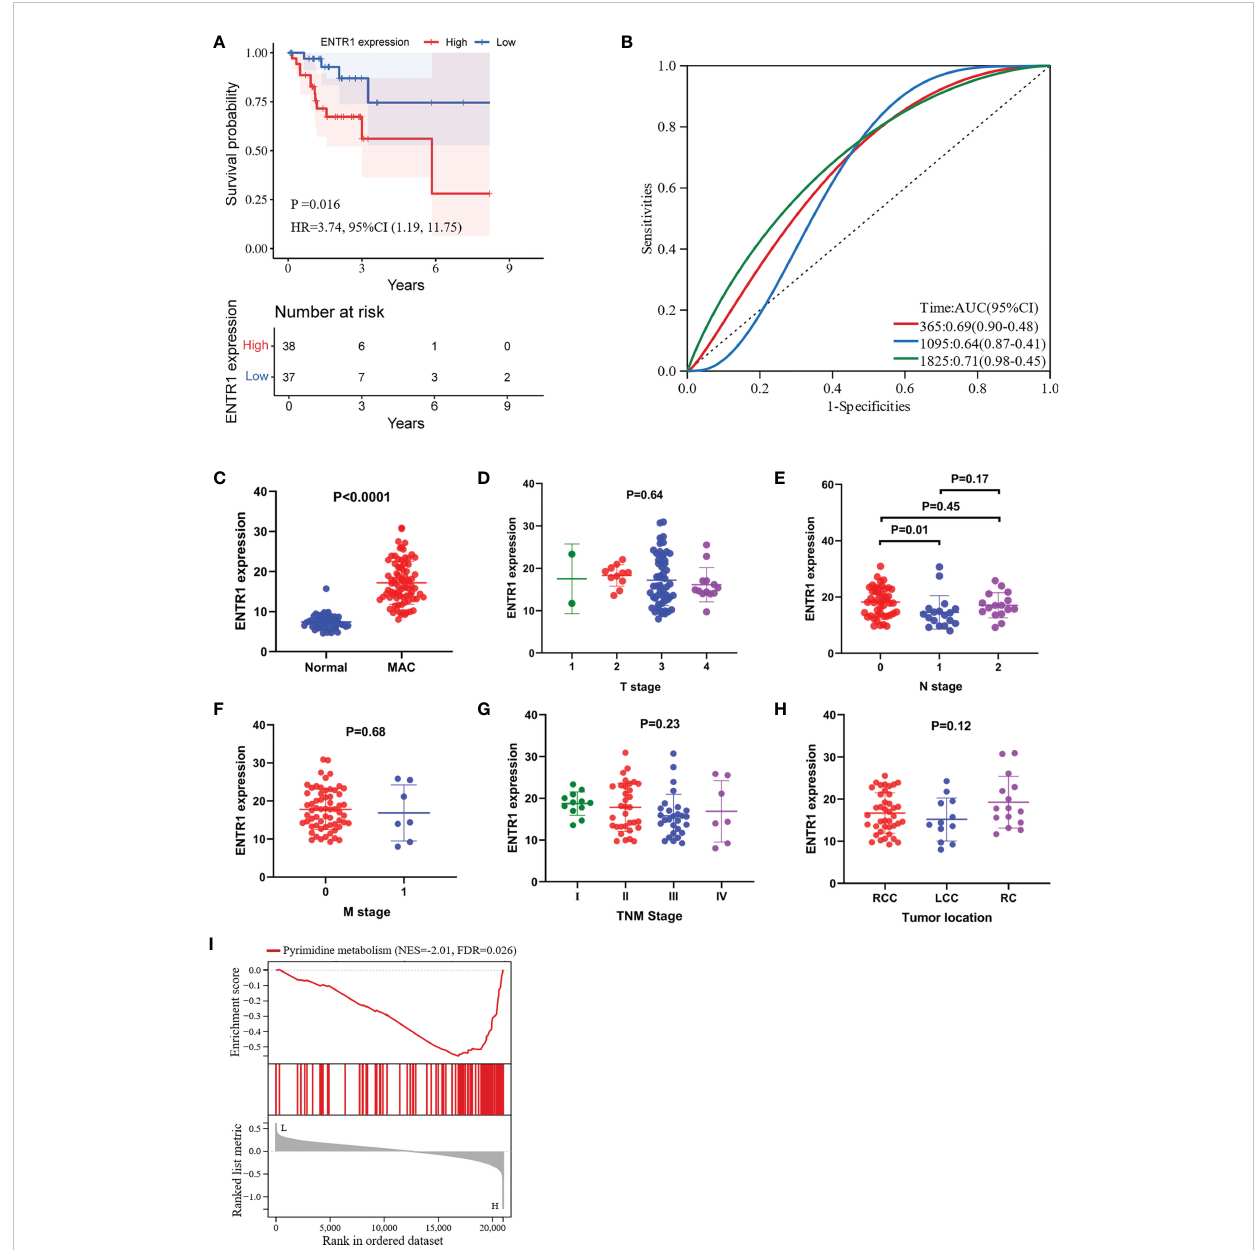
FIGURE 6 Visualization of the correlation between ENTR1 expression and clinical characteristics. GSEA of ENTR1. (A) Kaplan-Meier survival curves for the high- expression group and the low-expression group depending on ENTR1 expression. (B) ROC curves for ENTR1. (C) Differences in ENTR1 expression between normal and MAC tissues. (D) Differences in ENTR1 expression between different T stages. (E) Differences in ENTR1 expression between different N stages. (F) Differences in ENTR1 expression between different M stages. (G) Differences in ENTR1 expression between different TNM grades. T, tumor; N, regional lymph node; M, metastasis. (H) Differences in ENTR1 expression between different tumor locations. RCC, right-sided colon cancer. LCC, left-sided colon cancer. RC, rectal cancer. (I) GSEA of